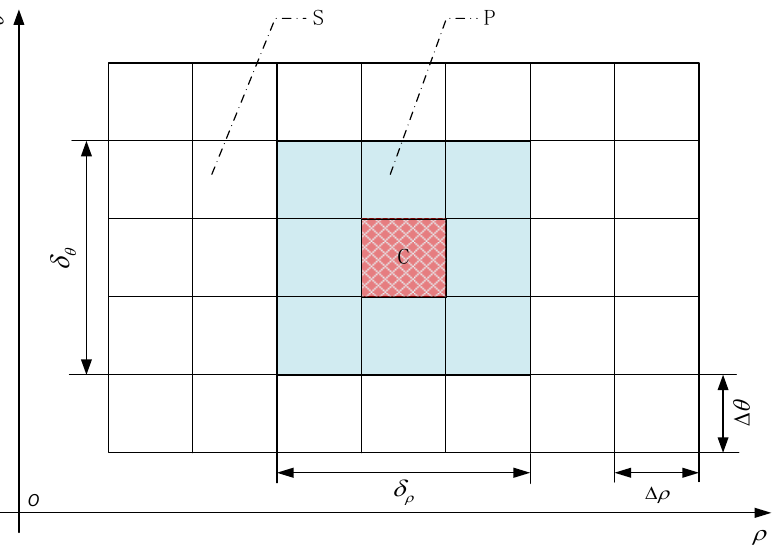
Figure 6. The zero Hough-transformed energy distribution evaluation scheme for the Hough transform-based GNSS interference detection techniques.